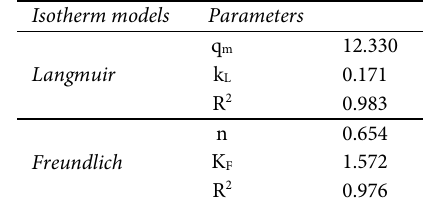
Table. 2. Adsorption isotherm parameters for As(III)